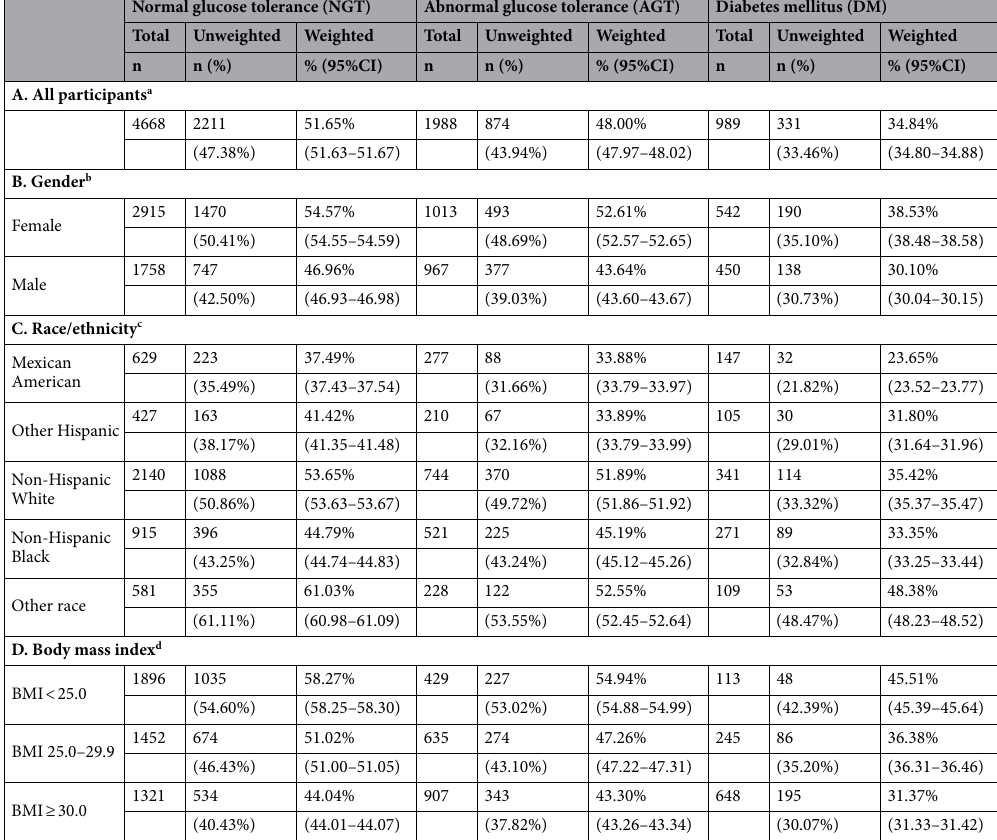
Table 6. Age-standardized seropositivity rates (%, with 95% confidence intervals [CI]) after hepatitis B vaccination, separated by glucose tolerance state. a P < 0.0001 for the weighted percent among three glucose tolerance states. b P < 0.0001 for weighted percent between both genders in all three states of glucose tolerance and for weighted percent among three states of glucose tolerance in both genders. c P < 0.0001 for weighted percent between among 5 racial/ethnic groups in all three states of glucose tolerance and for weighted percent among all three states of glucose tolerance in all 5 racial/ethnic groups. d P < 0.0001 for weighted percent between among 3 BMI categories in all three states of glucose tolerance and for weighted percent among all three states of glucose tolerance in all 3 BMI